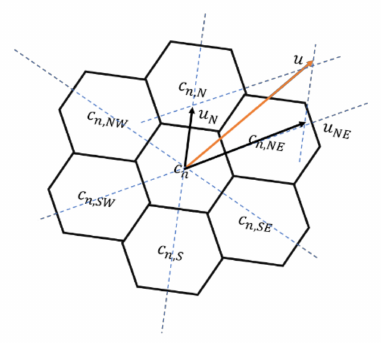
Figure 3. A hexagon and its neighborhood, with wind vector and its